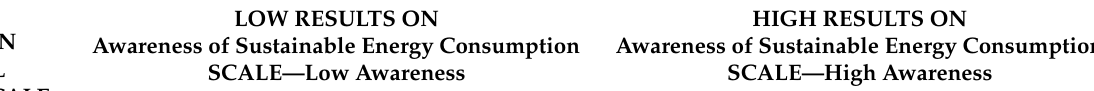
Table 2. Correlation between parental attitudes and awareness of sustainable energy consumption among young people with